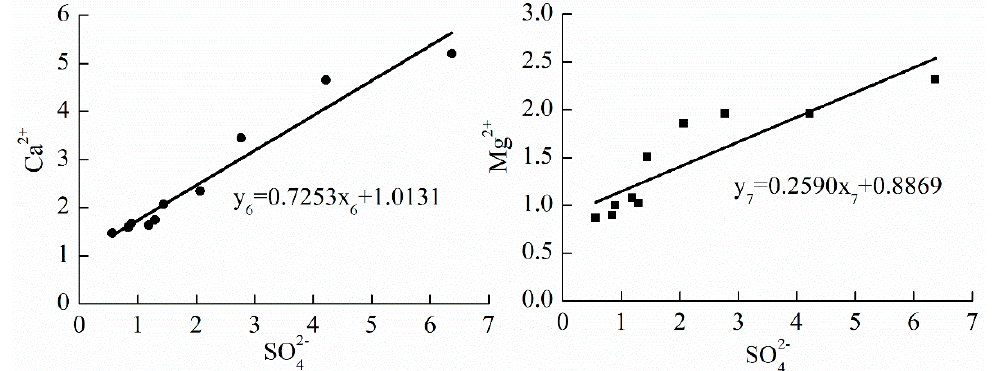
Figure 5. The relationship plots of Ca 2+ vs. SO 42 − and Mg 2+ vs. SO 42 − .